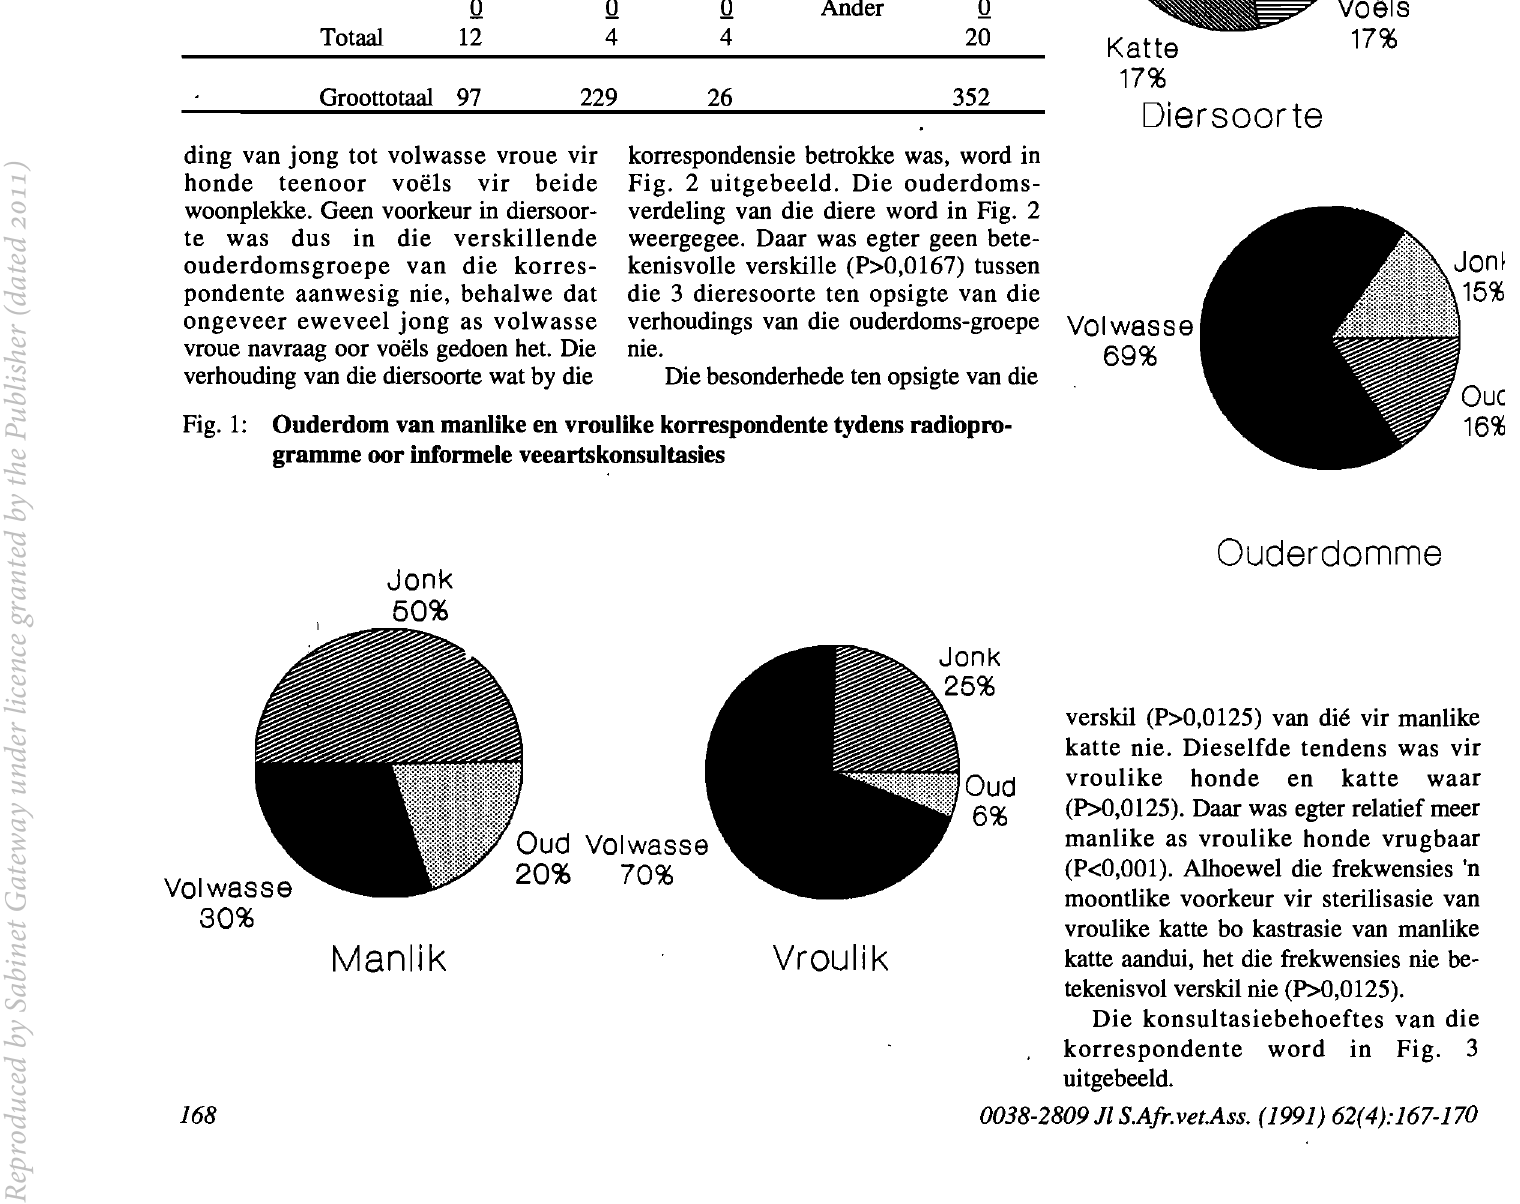
Fig. 2 uitgebeeld. Die ouderdoms